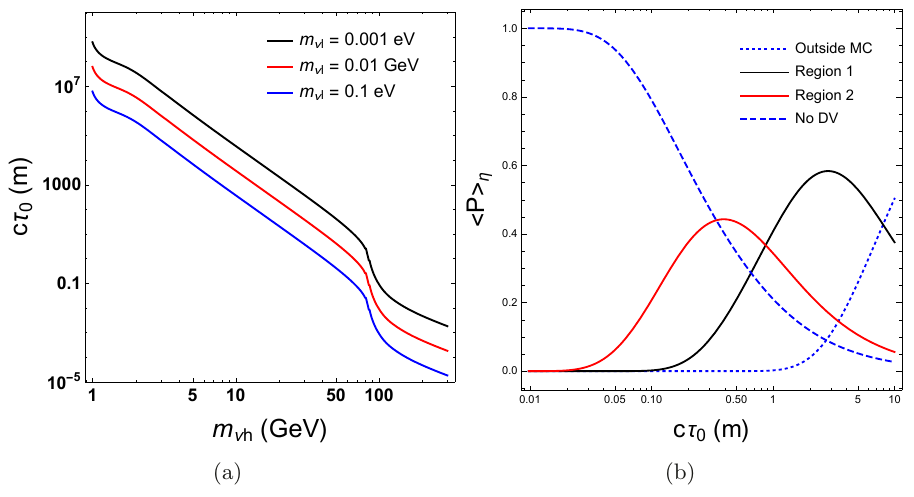
Figure 1 . (a) Proper decay length of the heavy neutrino as a function of the heavy neutrino mass m ν . (b) Averaged decay probability of the heavy neutrino for βγ = 1 in different regions of the h detector (see